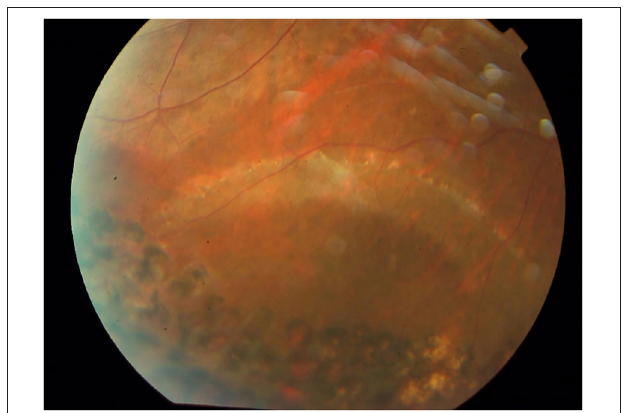
FIGURE 2 | Retinal break closure and retinal attachment were present with the laser scar formation at the final